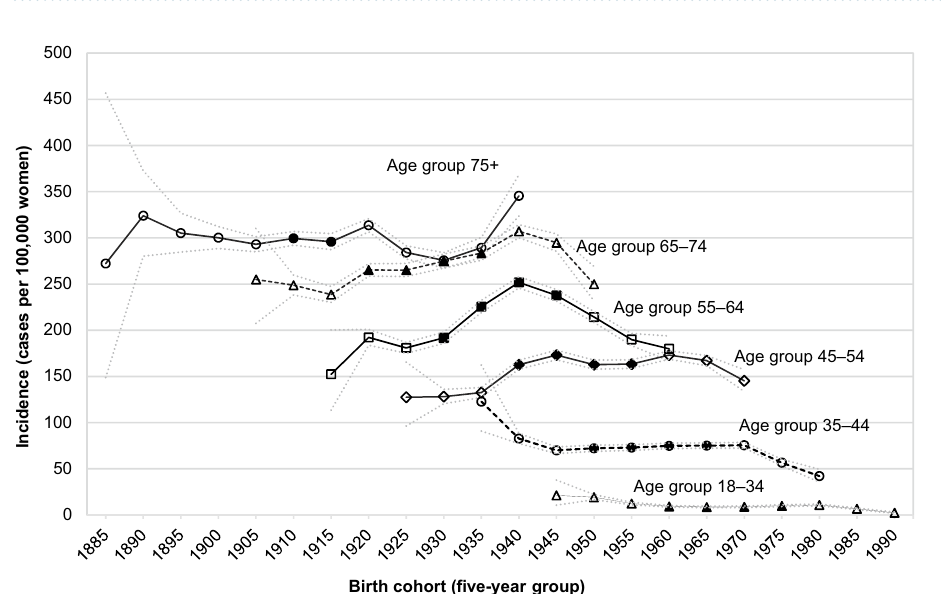
Figure 6. Age-specific incidence of breast cancer in Austrian females according to five-year birth cohorts, 1983–2017 (crude rates). Filled shapes indicate observations with fully captured age intervals without cut-offs due to exceeded observation limits (1983 and 2017). Dotted lines indicate 95% confidence